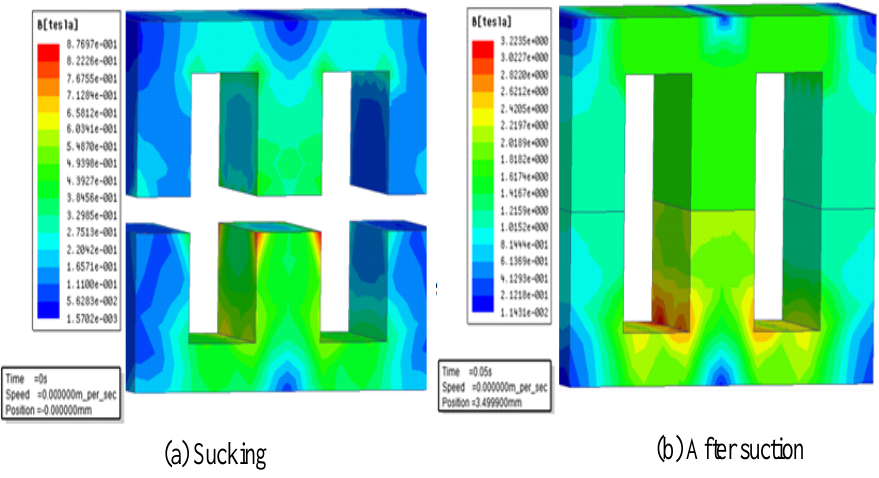
Figure 15. Contactor magnetic density distribution cloud at different times.